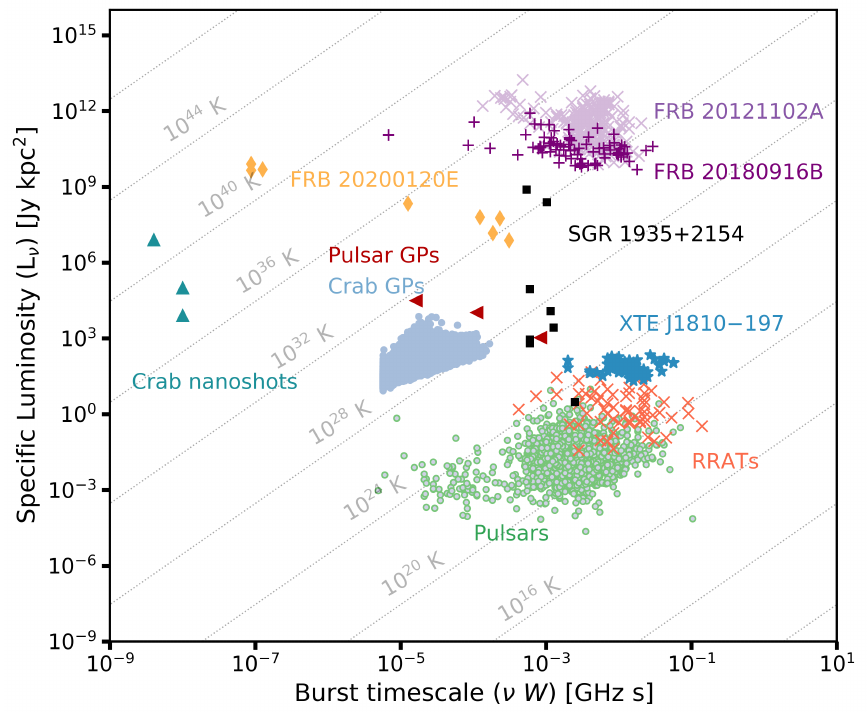
Figure 4. The ménagerie of short duration radio transients illustrating the various classes of events. The diagonal lines represent lines of constant brightness temperatures. For clarity of illustration, each pulsar and RRAT is represented by a single point, rather than their full brightness